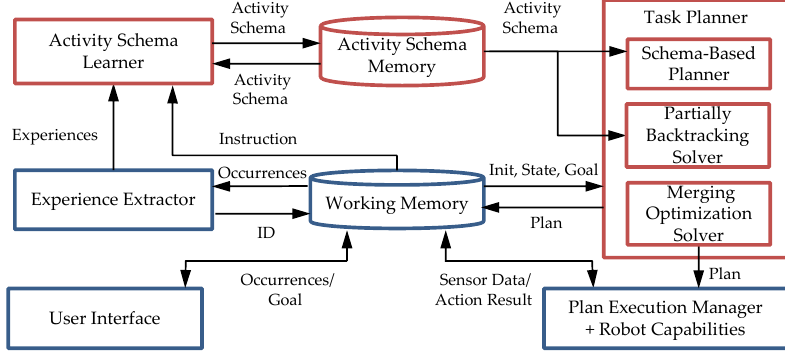
Figure 1. An overview of the learning and planning system.